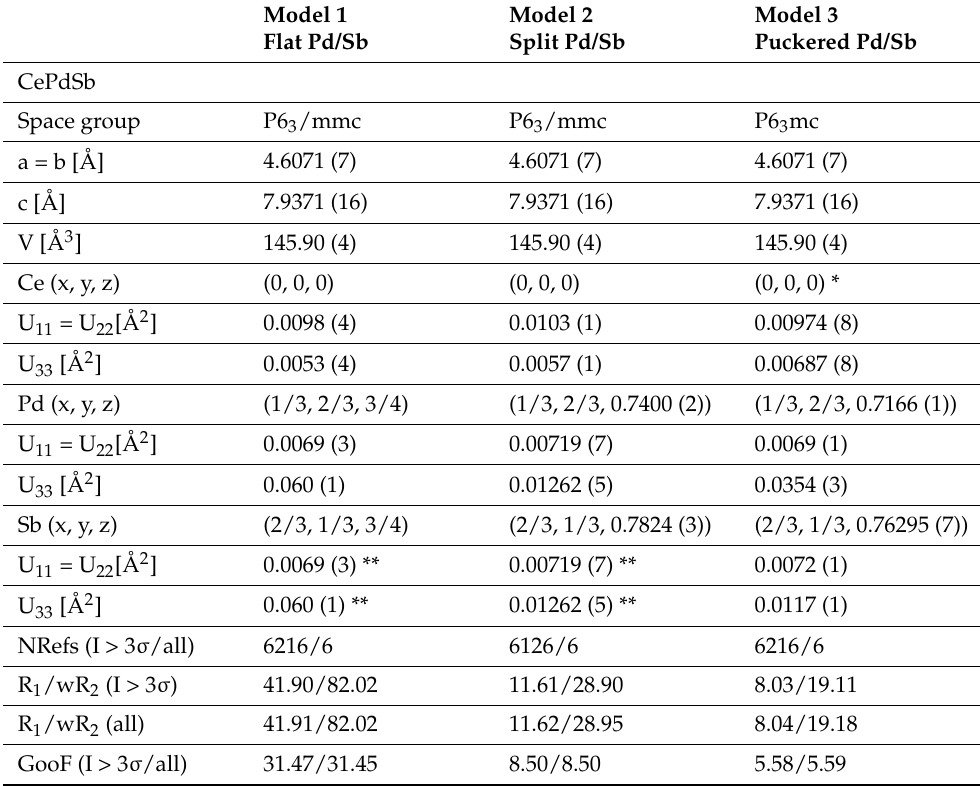
Table 2. Summary of crystallographic refinements for